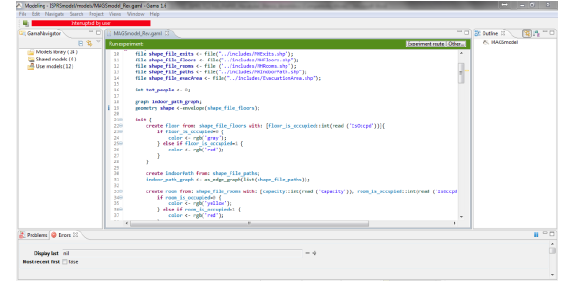
Figure 4. A screen capture image of the GAMA modeling interface